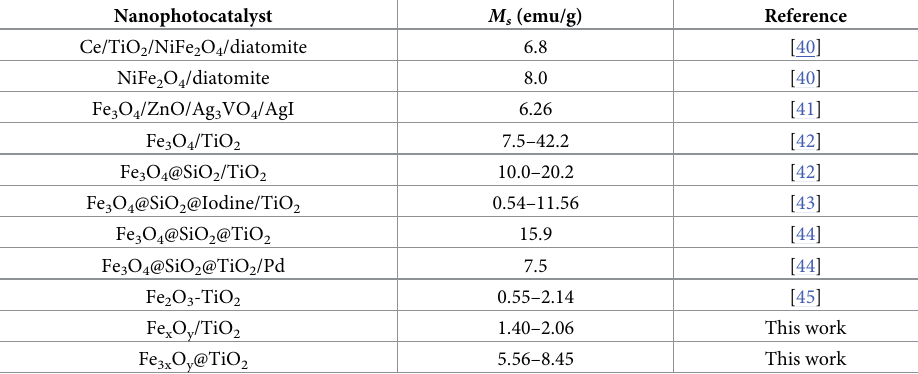
Table 1. Saturation magnetisms of reported magnetic